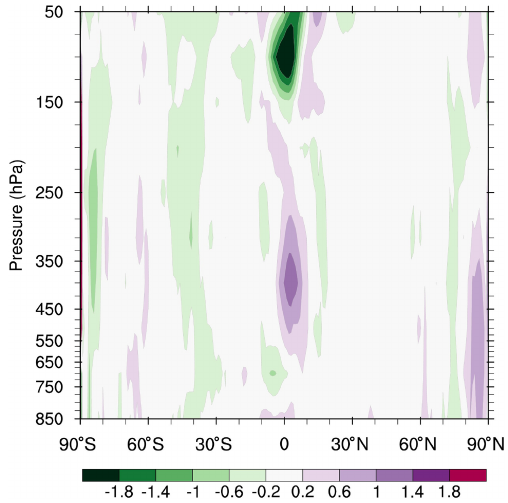
Figure 1. Zonal and time mean difference of ECMWF minus FV3GFS backgrounds (defined as 6h forecasts) for analysis times 00:00, 06:00, 12:00, and 18:00UTC) for zonal wind (ms − 1 ). Note that the sample in Figs. 1–15 is for 1–7 September